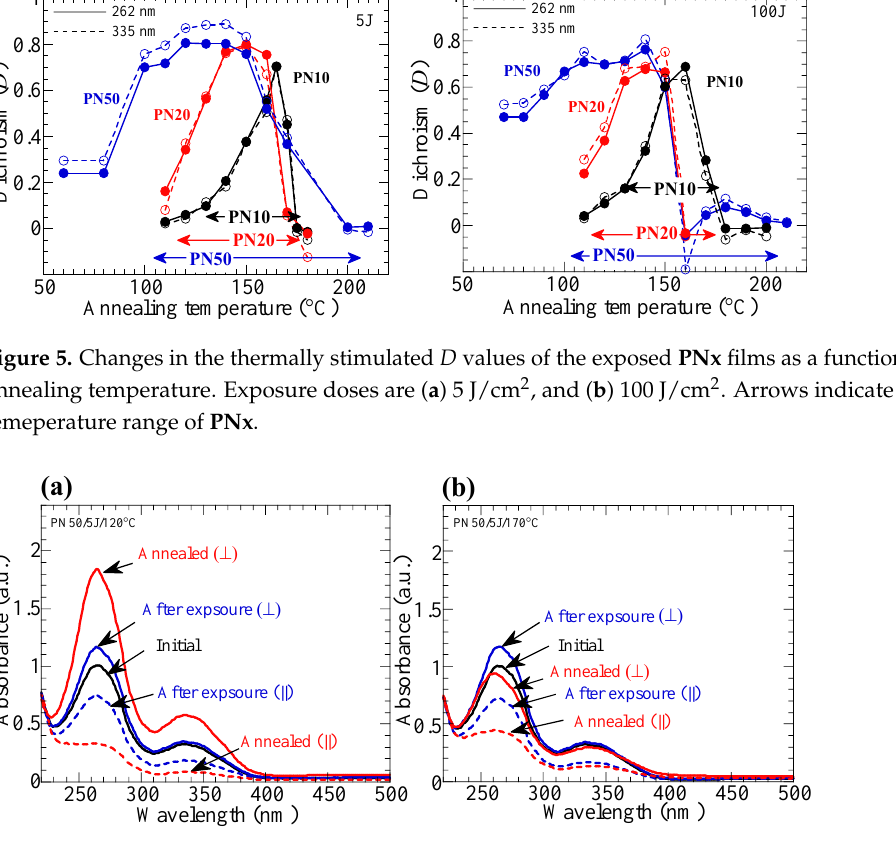
Figure 6. Changes in the polarized absorption spectra of the PN50 films before (black line) and after exposure (blue lines) to LP 365-nm light for 5 J/cm 2 and subsequent annealing (red lines) at ( a ) 120 °C, and ( b ) 170 °C for 10 min.